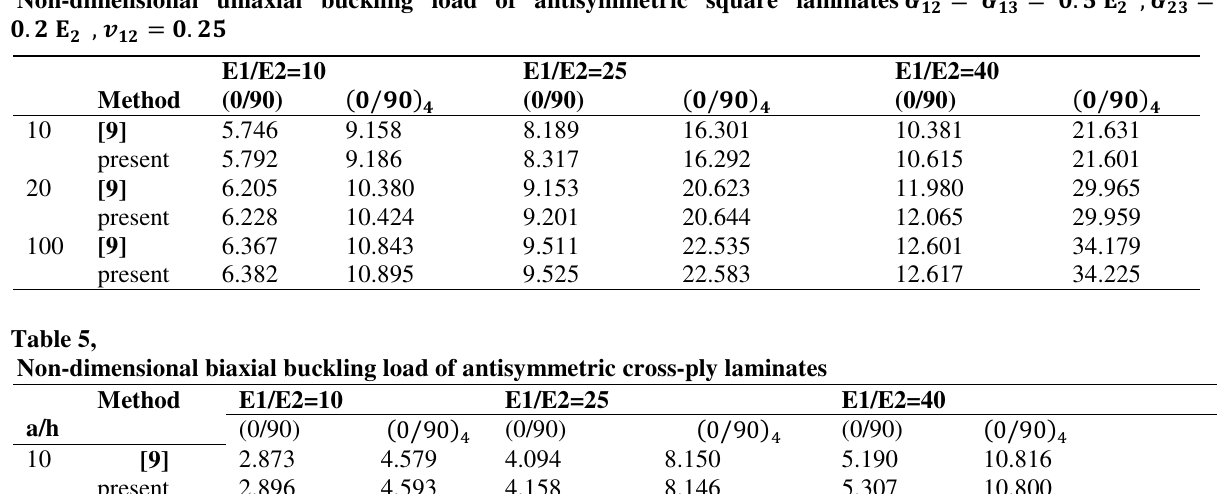
Non-dimensional uniaxial buckling load of antisymmetric square laminates